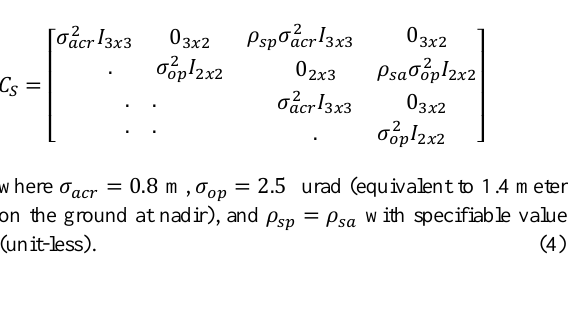
Figure 6. Stereo base (b) and height